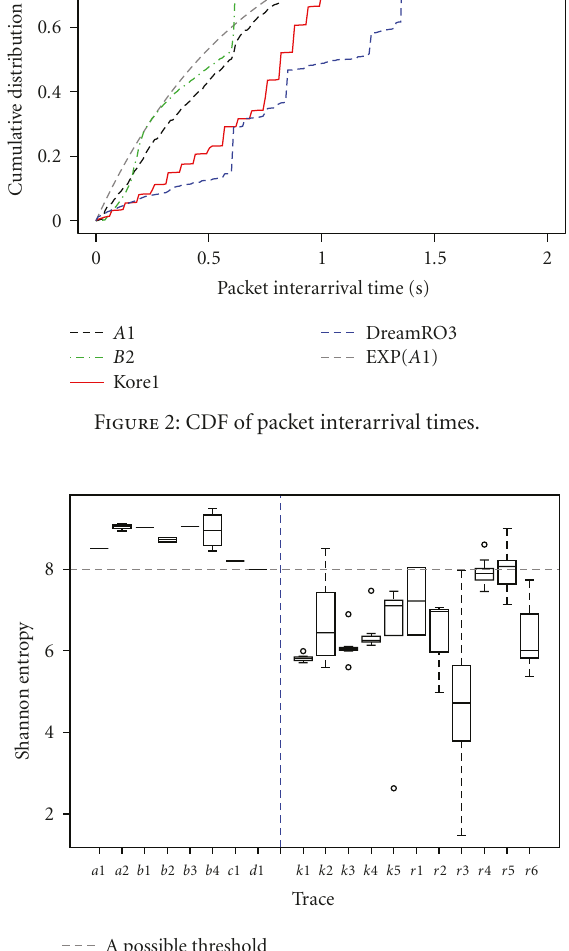
Figure 3: Entropy computed from packet interarrival times for each trace. Each group of 5000 interpacket times is computed separately. The threshold is chosen arbitrarily to reveal that the entropy of player tra ffi c is almost always higher than that of bot tra ffi